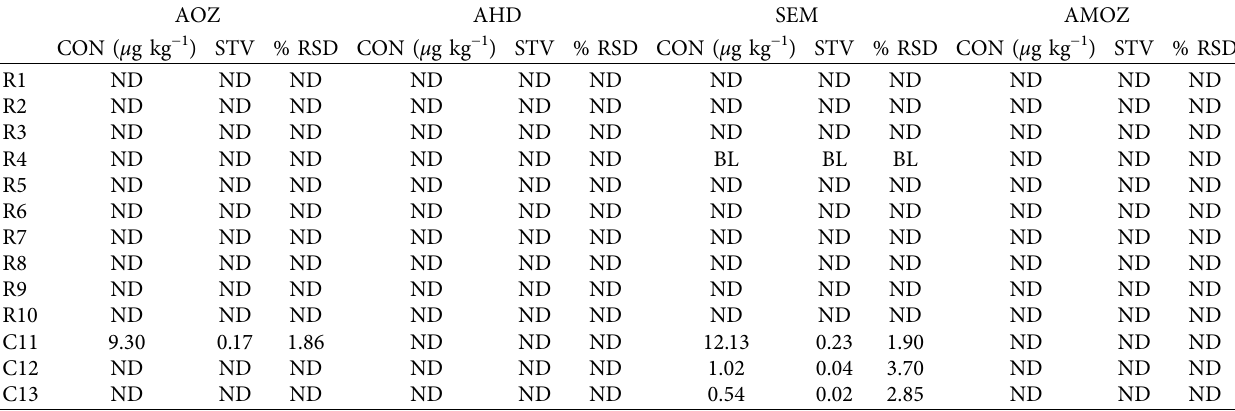
Table 3: Detection of NF metabolites in HHF products purchased